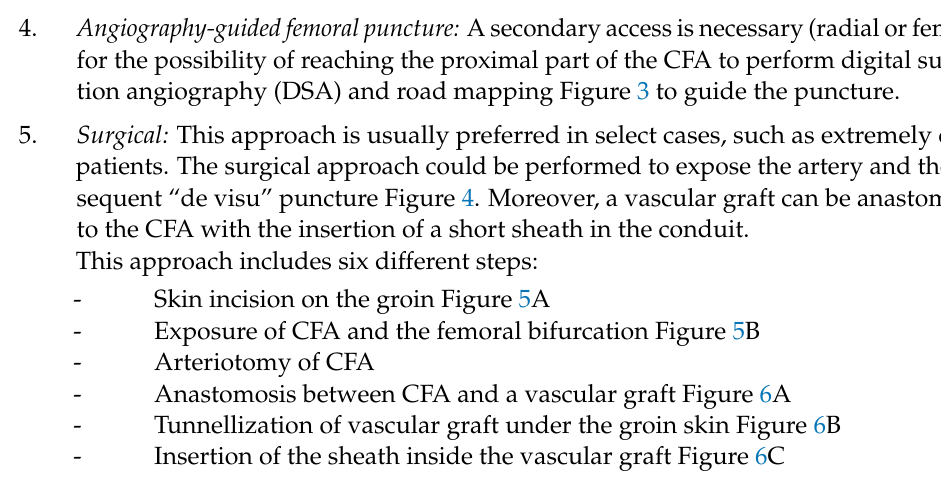
Figure 2. Initial step to perform ultrasound-guided puncture. ( A ) Identify lower edge of femoral edge with fluoroscopy and a metal hemostat. ( B ) Write a sign in the skin with a marker in the correspondent point. ( C ) The probe positioned above the marked line.